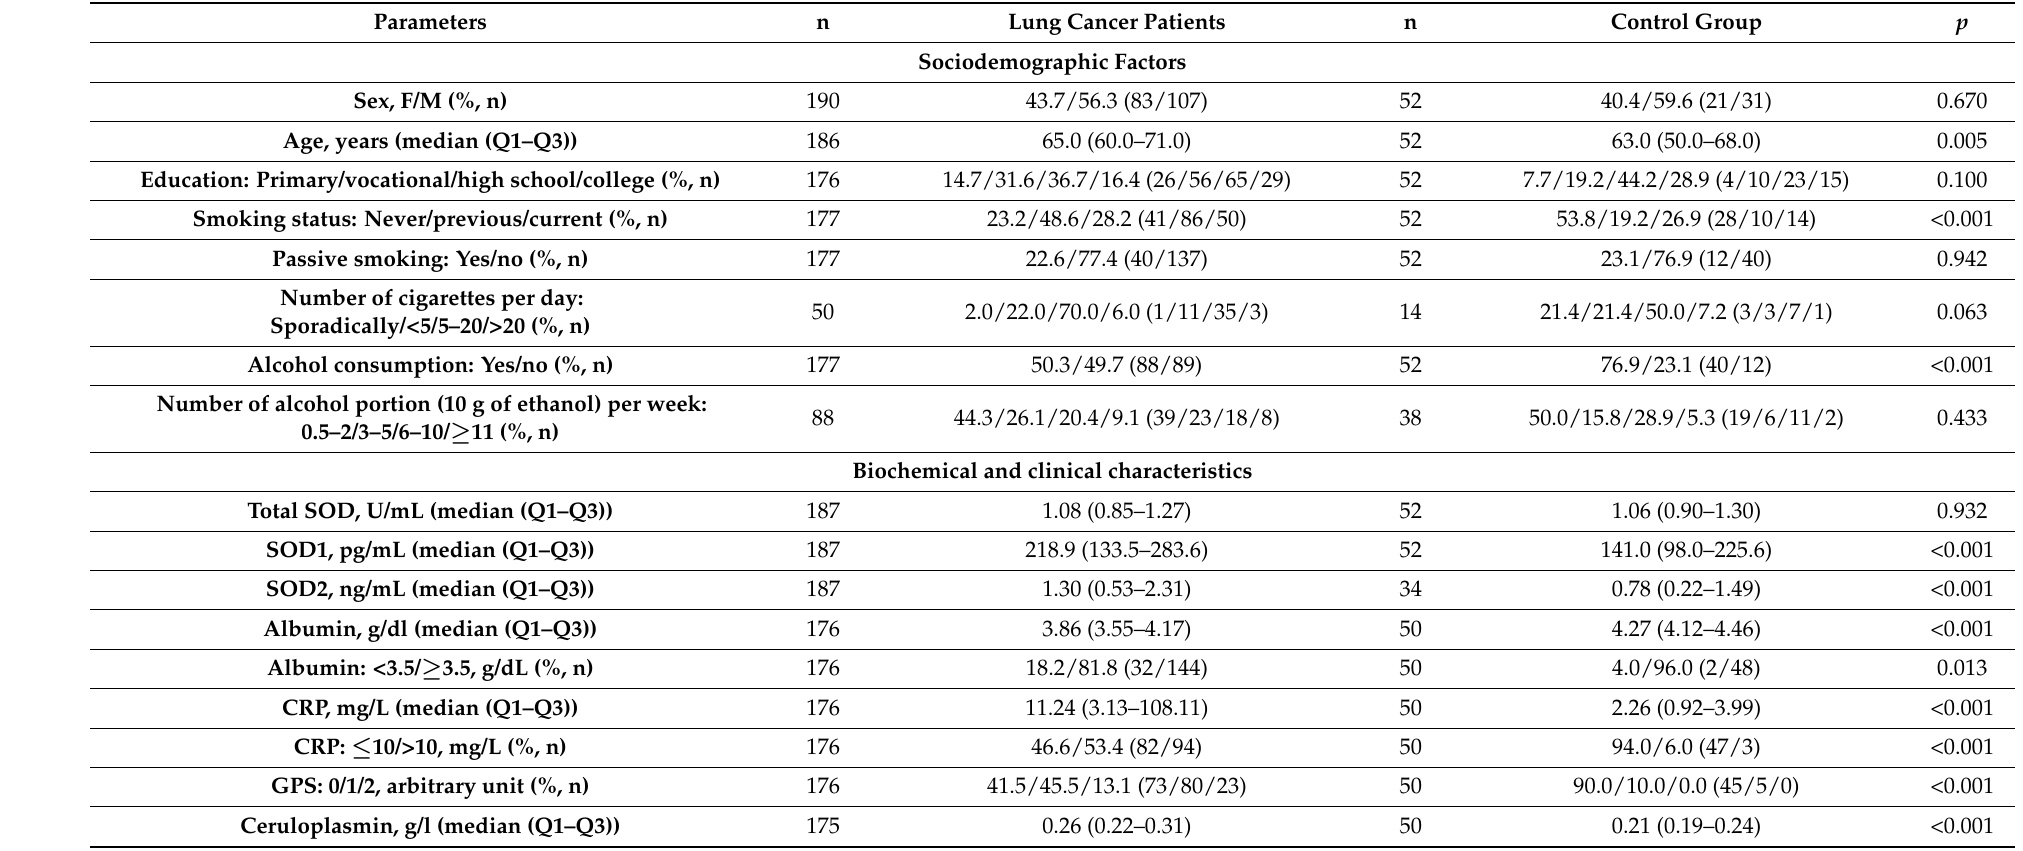
Table 1. Baseline characteristic of lung cancer patients and the control